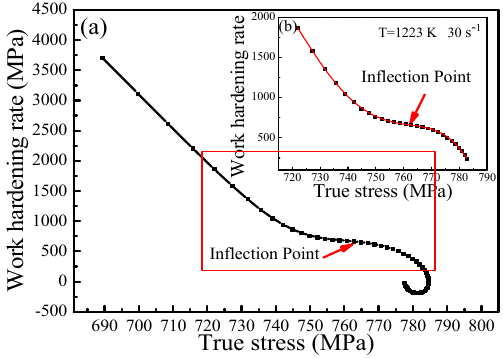
Figure 8. The plot of θ ~ σ at 1223 K and 30 s ‐ 1 .